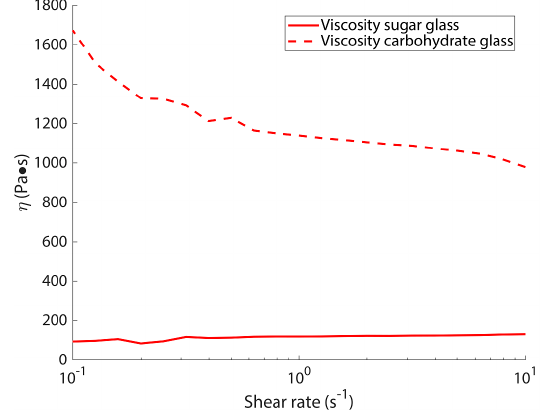
Figure A2. Viscosity determined via continuous shear experiments and the shear rate dependency at 90 °C for both sugar glass and carbohydrate glass.